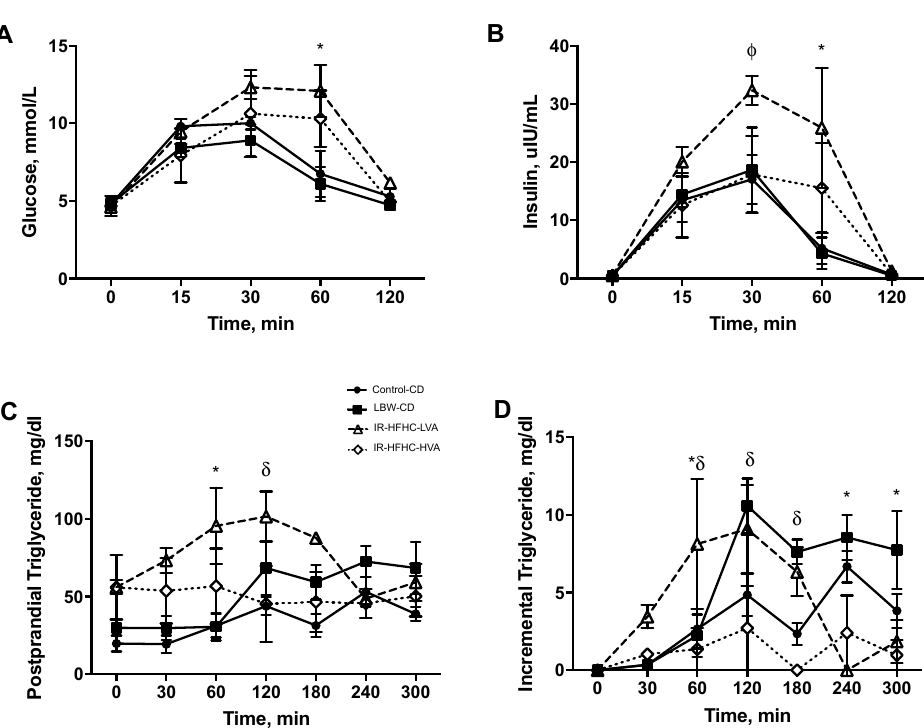
Figure 2. ( A ) Postprandial glucose and ( B ) insulin response following a modified oral glucose challenge. Values are means ± SEM, n = 6 Control-Control Diet (CD) (black circles), n = 4 LBW-CD (black squares), n = 3 IR-HFHC-LVA (open triangles), n = 4 IR-HFHC-HVA (open diamonds). (*) denotes statistical difference between LBW-CD and IR-HFHC-LVA ( p value < 0.05). ( φ ) denotes trend between IR-HFHC-LVA vs. IR-HFHC-HVA ( p value = 0.09) ( C ) Postprandial triglyceride and ( D ) incremental triglyceride response following a modified oral glucose and fat challenge (MOGTT). Values are means ± SEM, n = 6 Control-CD (black circles), n = 4 IR-CD (black squares), n = 3 IR-HFHC-LVA (open triangles), n = 4 IR-HFHC-HVA (open diamonds). AUC is shown (inset). (*) denotes statistical difference between LBW-CD and IR-HFHC-LVA ( p value < 0.05) and ( δ ) denotes statistical difference between IR-HFHC and IR-HFHC-HVA ( p value <